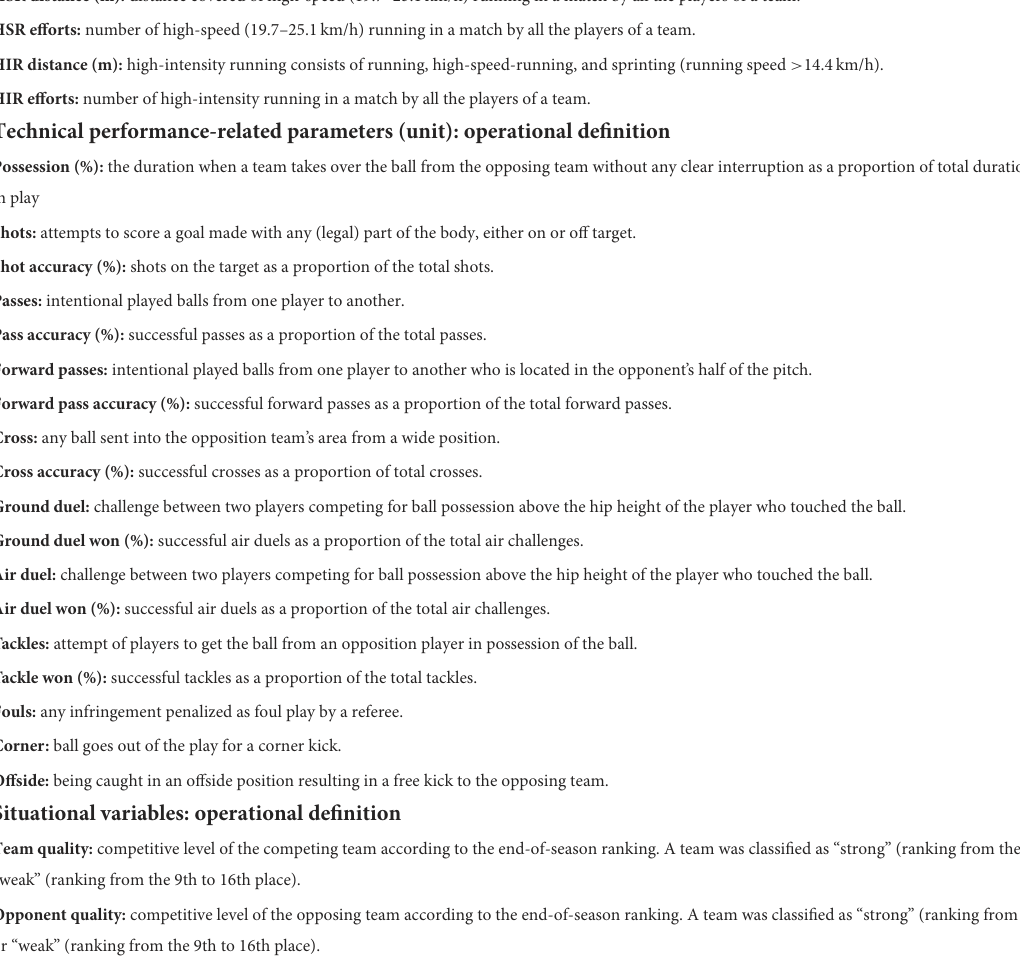
Technical performance-related parameters (unit): operational definition